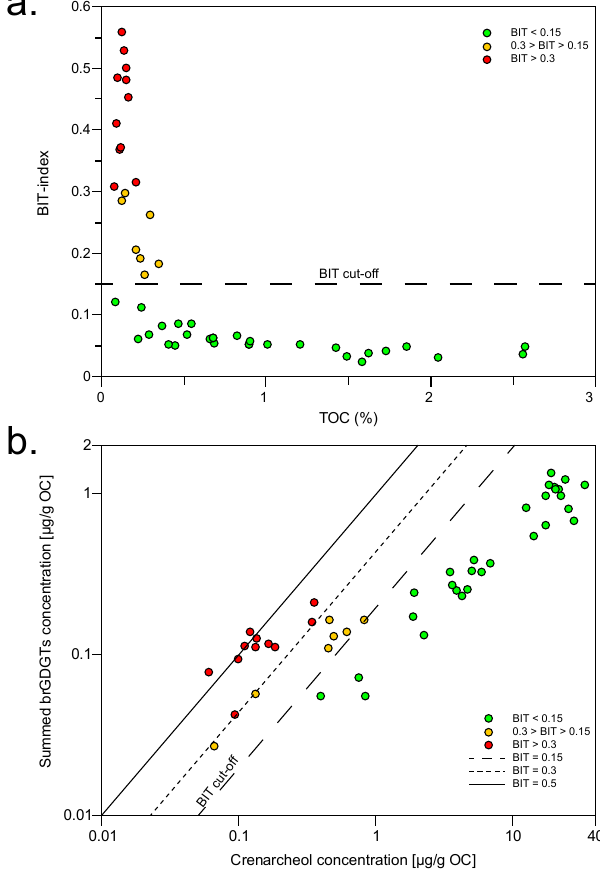
Figure 5. (a) Cross plot of summed brGDGTs (µgg − 1 OC) against crenarcheol (µgg − 1 OC) on a logarithmic axis. (b) Cross plot of BIT index values against total organic carbon